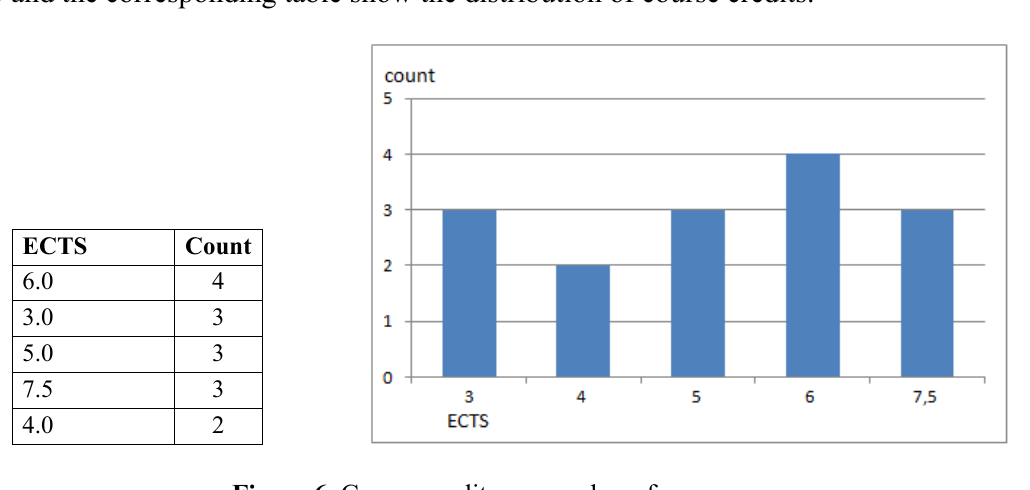
Figure 6. Course credits vs. number of